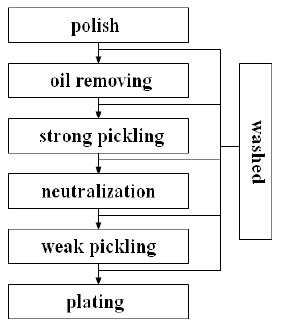
Figure 1. The flow chart of substrate pre-treatment. Table 1. Formula of plating solution and operating conditions.